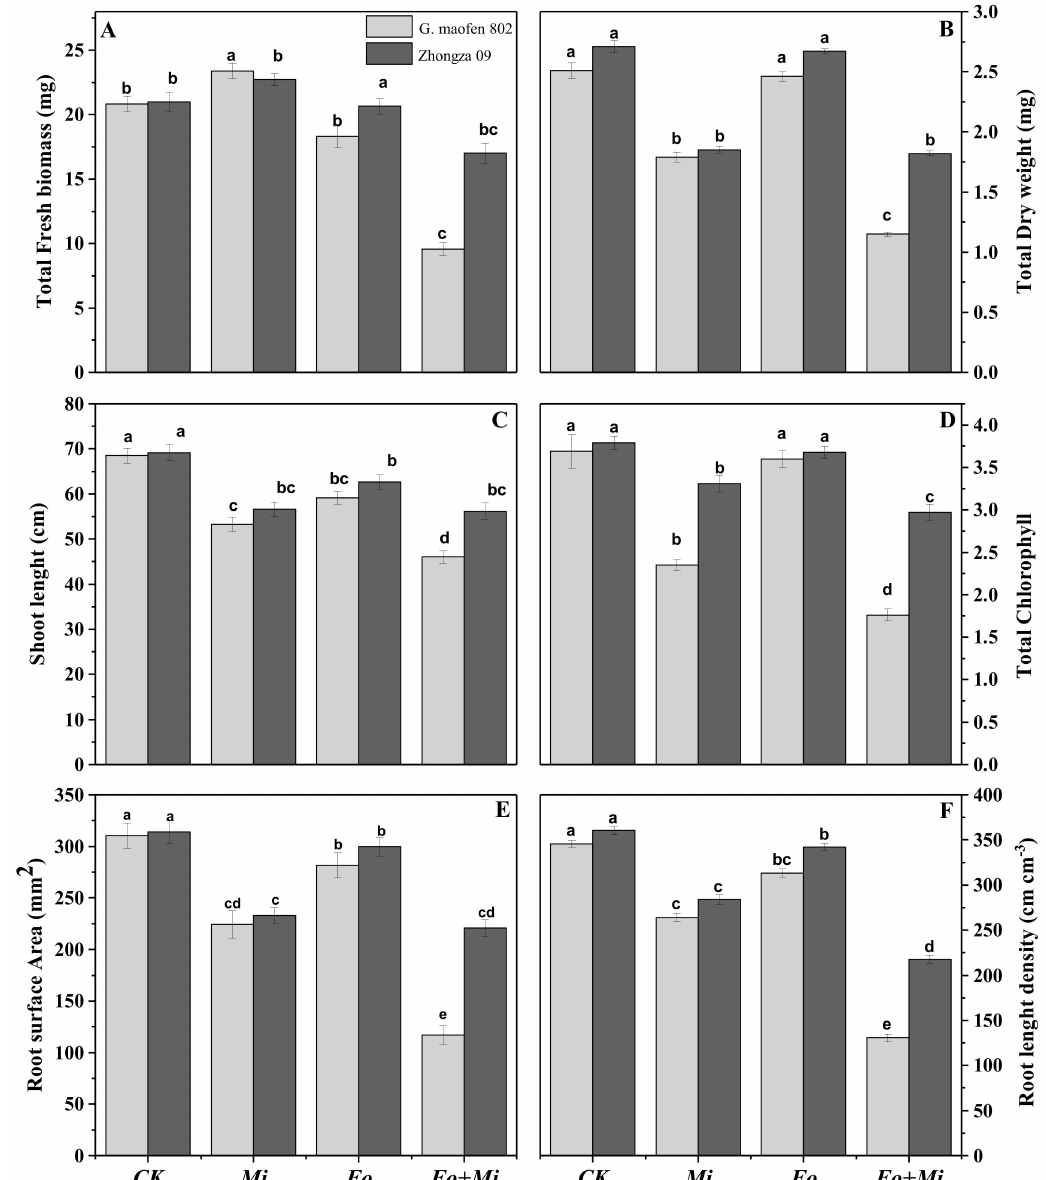
Figure 1. E ff ects of Fusarium oxysporum and Meloidogyne incognita alone and in combination on the growth ( A – C ) and physiological ( D ) and root ( E , F ) attributes of two tomato cultivars (G. maofen 802 and Zhongza 09) at 14 days after inoculation (DAI) under greenhouse conditions. Note: CK, non-inoculated control; Fo , Fusarium oxysporum ; Mi , Meloidogyne incognita ; Fo + Mi , Fusarium oxysporum + Meloidogyne incognita. Bars showing dissimilar lower-case letters are statistically di ff erent from each other at p ≤ 0.05 (Tukey–Kramer test). Values are mean ±